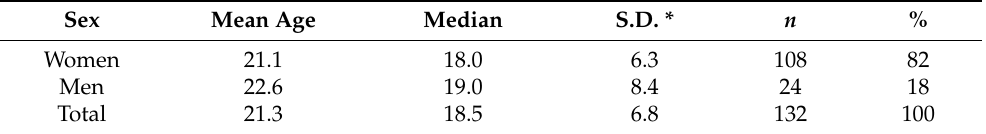
Table 2. Sex and age of participants. Sex Mean Age Median